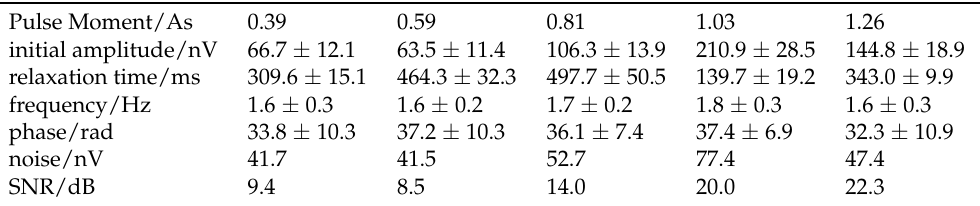
Table 1. Fitting parameters of the measured UMRS signals.